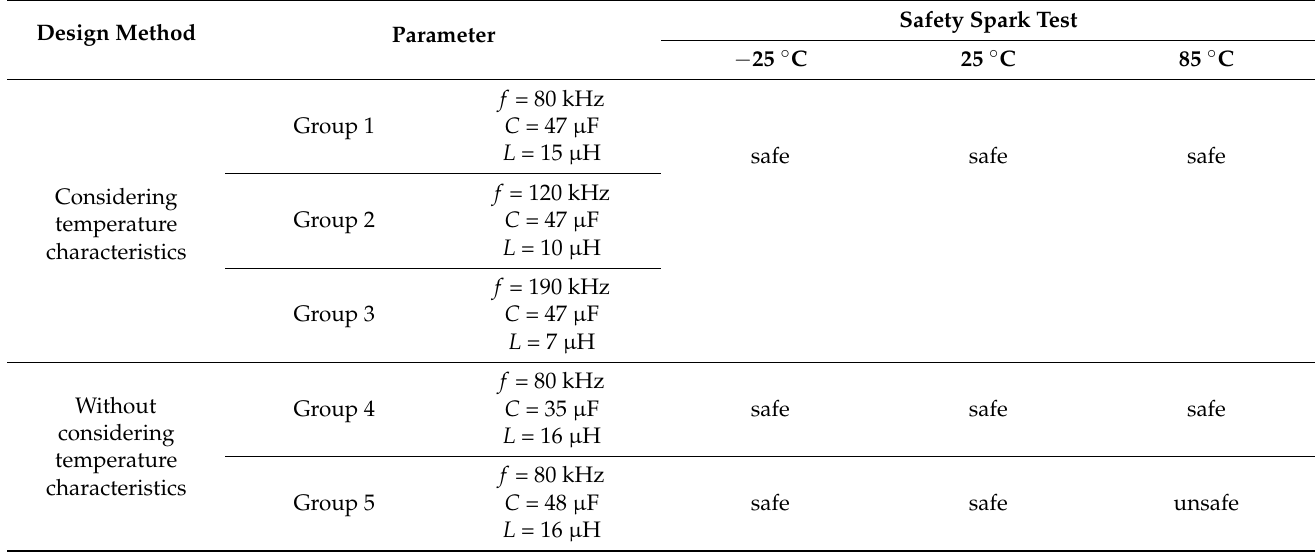
Table 3. Safety spark test results of the